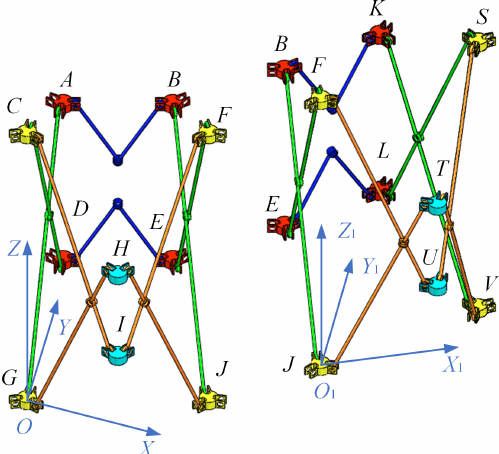
Figure 13. Combined mechanism comprised of two units and its coordinate